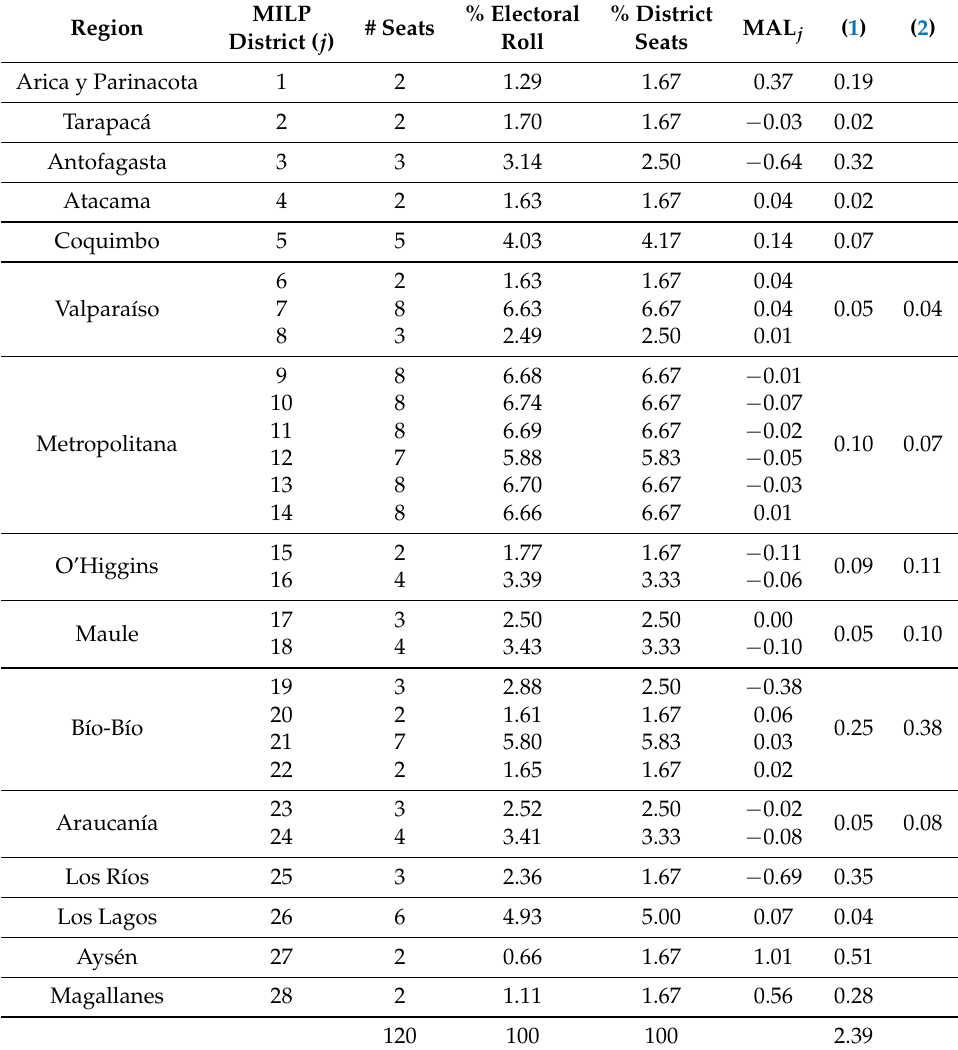
Table A1. Summary of the malapportionment levels obtained for the districting design of a Chamber of Deputies considering 120